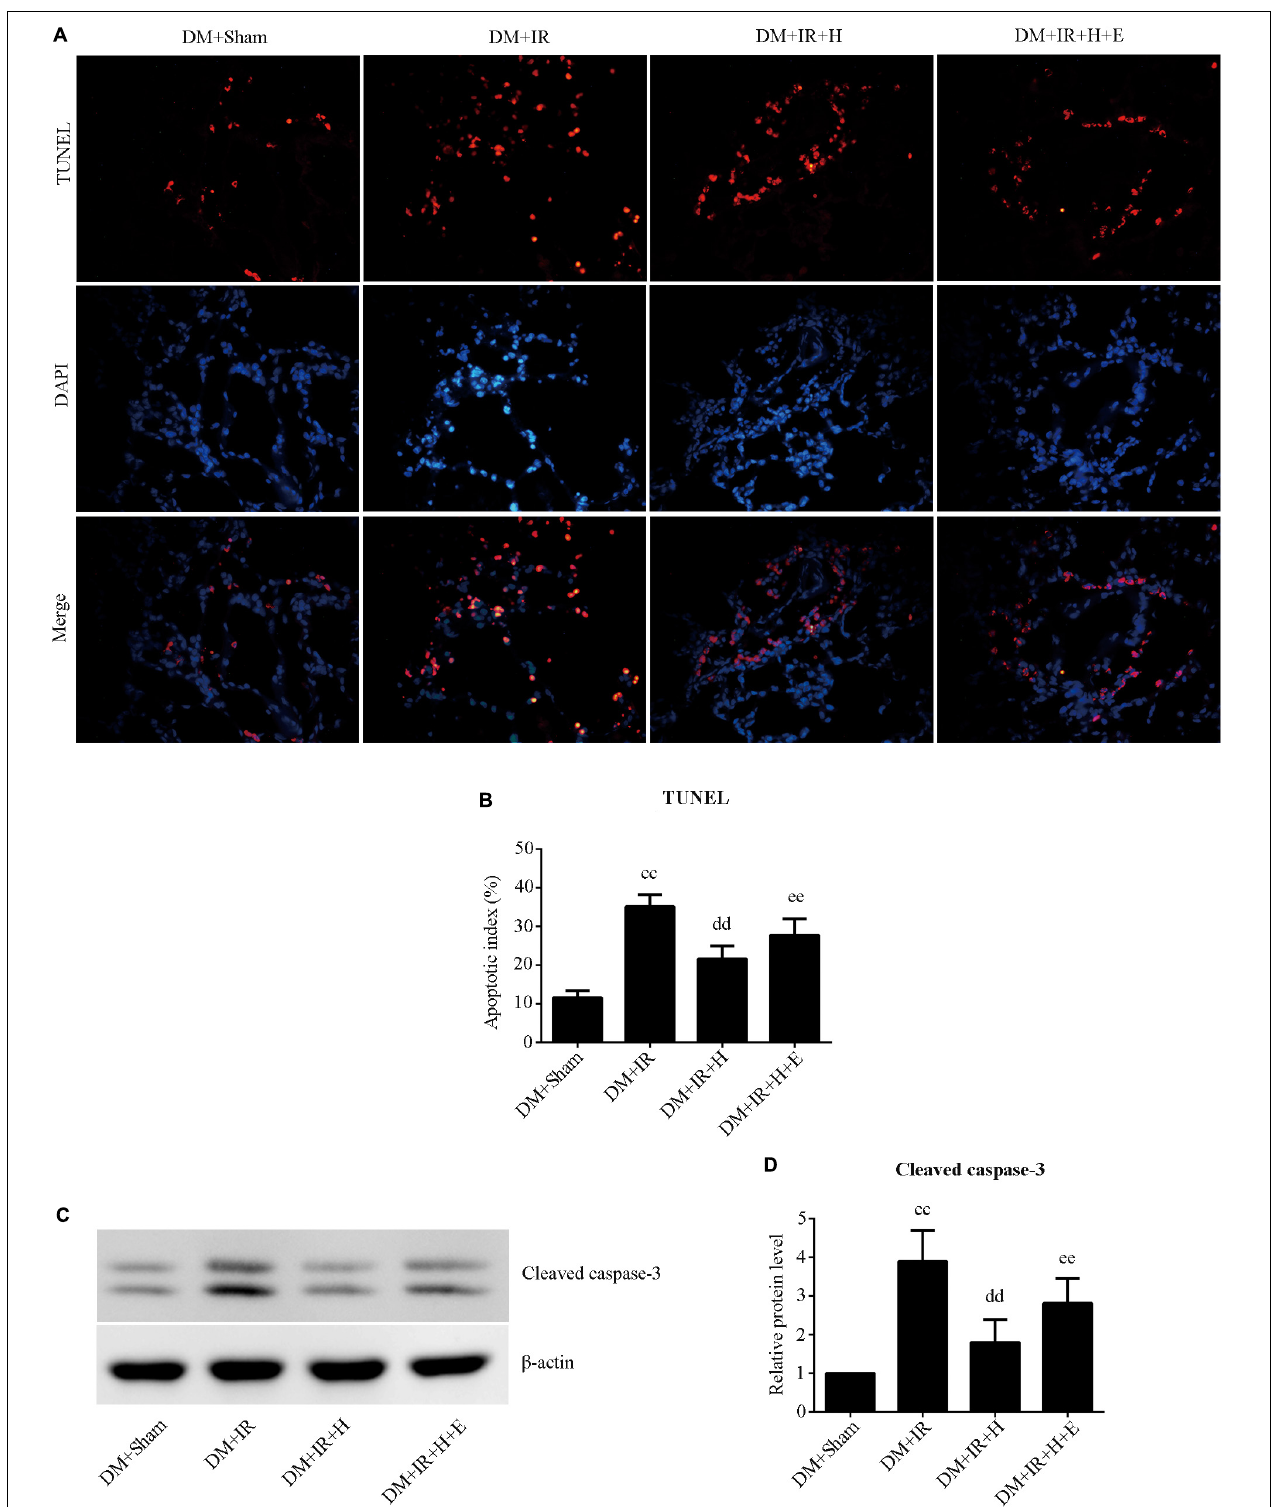
FIGURE 6 | EX527 compromised H 2 S-induced amelioration of the cell apoptosis in diabetic lung IR injury. (A) Representative in situ detection of lung parenchymal cell apoptosis by TUNEL staining. (magnification: 400 × ). (B) Percentage of TUNEL-positive nuclei. (C) Representative blots. (D) Cleaved caspase-3 expression. TUNEL, Terminal deoxynucleotidyl transferase dUTP nick end-labeling ( cc P < 0.01 versus DM + sham group, dd P < 0.01 versus DM + IR group, ee P < 0.01 versus DM + IR + H group; n = 8 in each group).